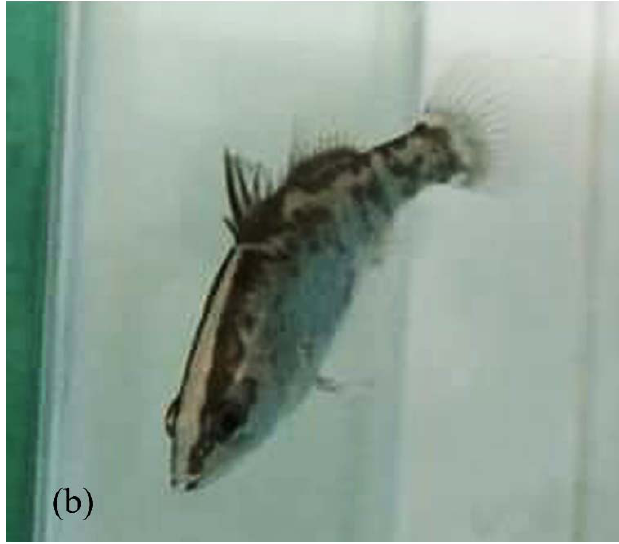
Figure 1. Barramundi Lates calcarifer juvenile in the typical waiting pose in an experimental aquarium: profile ( a ) and front ( b ) view.